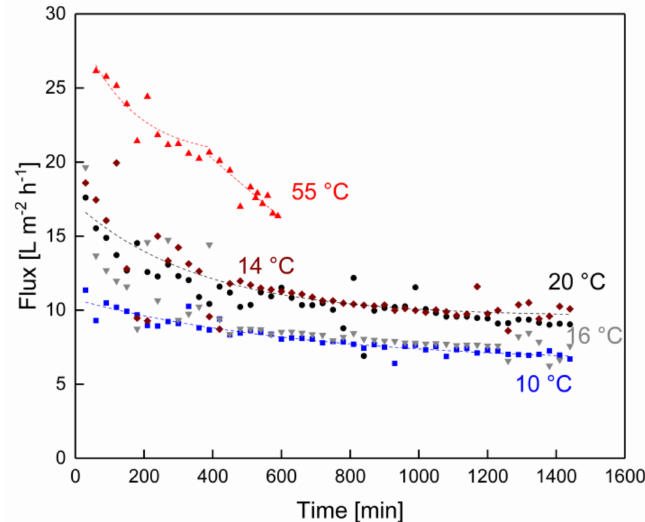
Figure 2. Flux as a function of the filtration time at processing temperatures of 10 ( (cid:4) ), 14 ( (cid:95) ), 16 ( (cid:72) ), 20 ( • ), and 55 ◦ C ( (cid:78) ). Dotted lines are guides for the